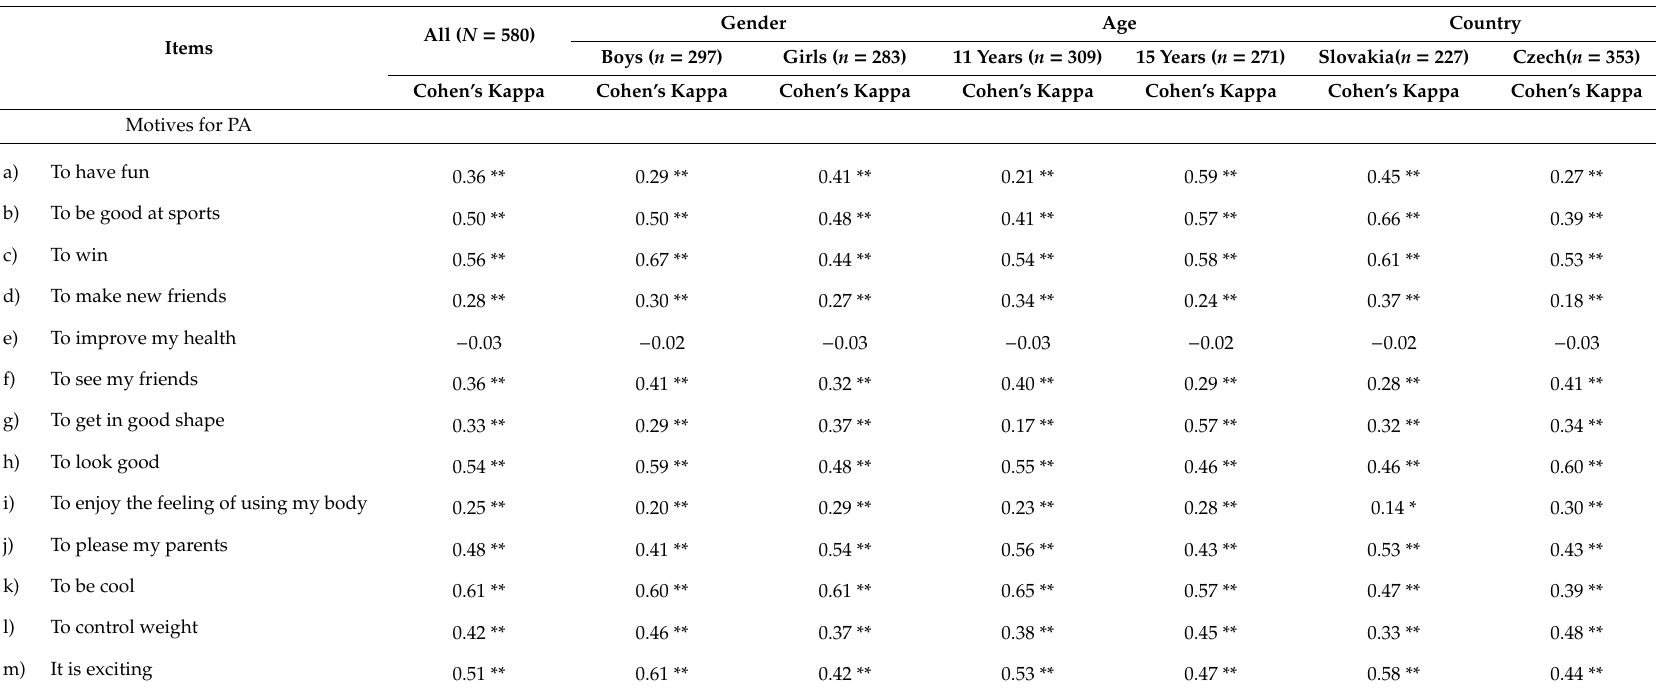
Table 3. Cohen’s Kappa coe ffi cients with dichotomized variables for Health Behavior in School-Aged Children (HBSC) items regarding motives for physical activity by gender, age group and country (Slovakia and Czech Republic,